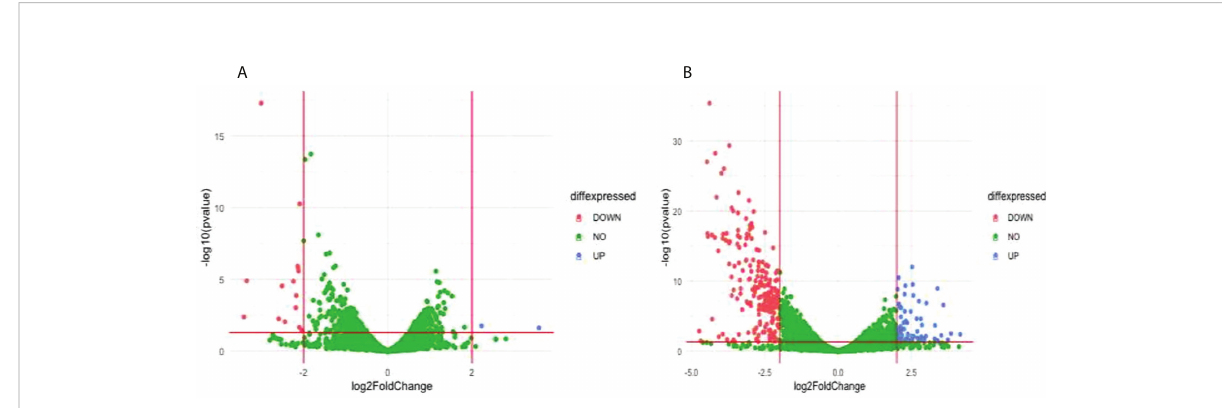
FIGURE 5 Differentially expressed genes (DEG) between compared conditions for the R539T parasite line. Scatter plots indicate the genes differentially expressed (log2 fold expression change > 2 and with a p-value < 0.05). Red vertical lines indicate absolute log2 fold change >2 and red horizontal line indicates p-value < 0.05. (A) Volcano plot for R539T_DMSO treated versus R539T_DHA treated; 15 genes were downregulated and 2 genes upregulated (B) Volcano plot for R539T_untreated compared with R539T_DHA; 70 genes upregulated, and 217 genes were